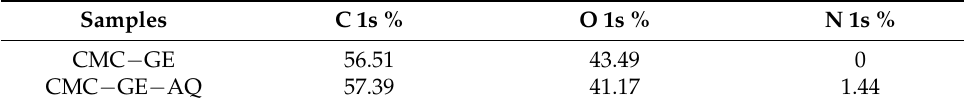
Figure 1. FT−IR spectra of CMC−GE−AQ, CMC−GE, CMC−Na and AQ. Figure 1. FT-IR spectra of CMC − GE − AQ, CMC − GE, CMC − Na and AQ. The covalent load of AQ on the CMC − GE surface was further confirmed by XPS. The The covalent load of AQ on the CMC−GE surface was further confirmed by XPS. The XPS spectra of CMC − GE and CMC − GE − AQ are shown in Figure 2. In Figure 2a, only XPS spectra of CMC−GE and CMC−GE−AQ are shown in Figure 2. In Figure 2a, only C 1s and O 1s absorption were found in CMC−GE. In Figure 2b, C 1s, O 1s, and N 1s absorption were found in CMC−GE−AQ. In Figure 2c, the absorptions of CMC−GE are located at 284.96, 286.56 and 287.76, which are C−C, C−O, and O−C=O bonds, respectively. In Figure 2d, the peak of CMC−GE−AQ found at 288.76 eV appeared because of the C=N bond. The bond. The XPS analysis survey scans of CMC − GE and CMC − GE − AQ are shown in XPS analysis survey scans of CMC−GE and CMC−GE−AQ are shown in Table 1. The N Table 1. The N content (1.44%) appeared in CMC − GE − AQ after the introduction of AQ, and C content changed from 56.51% to 57.39%. Thus, the conclusion of XPS confirmed that AQ was successfully introduced to CMC − GE. cessfully introduced to CMC−GE. Table 1. XPS analysis survey scans of CMC − GE and CMC − GE − Table 1. XPS analysis survey scans of CMC−GE and CMC−GE−AQ.